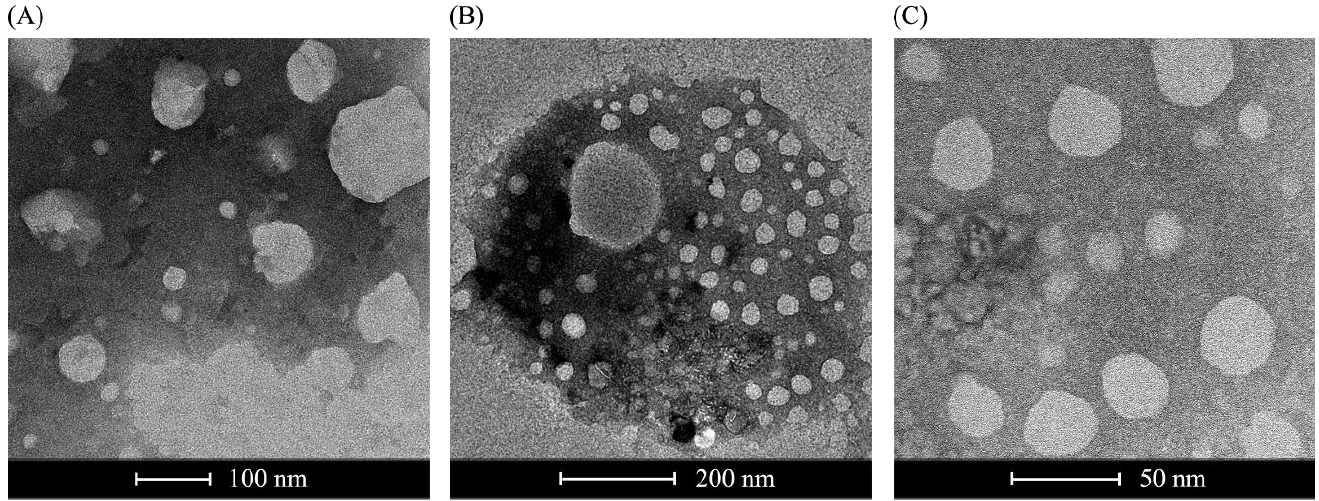
Figure 2. NS-TEM (negative-stained transmission electron microscopy) images of the formulated liposomes showing the final size of packaged replicons/samRNAs. ( A ) Cationic liposomes alone; ( B ) cationic liposomes complexed with 1 µ g of GFP replicon; and ( C ) cationic liposomes complexed with 1 μg of nLuc replicon. Data scales of 100 n m, 200 nm and 50 nm, respectively.